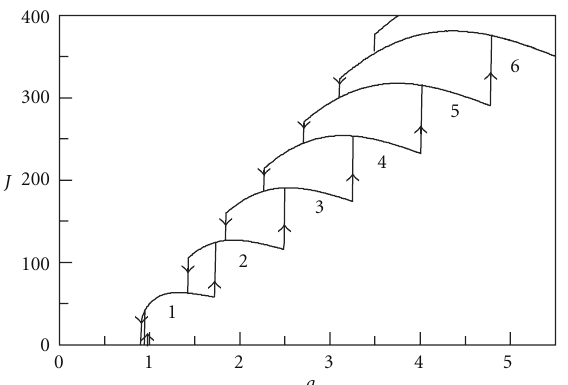
Figure 4: Dependence of the intracavity radiation energy J in established operation on pumping a . Digits indicate a number of pulses in a laser cavity for a corresponding branch.